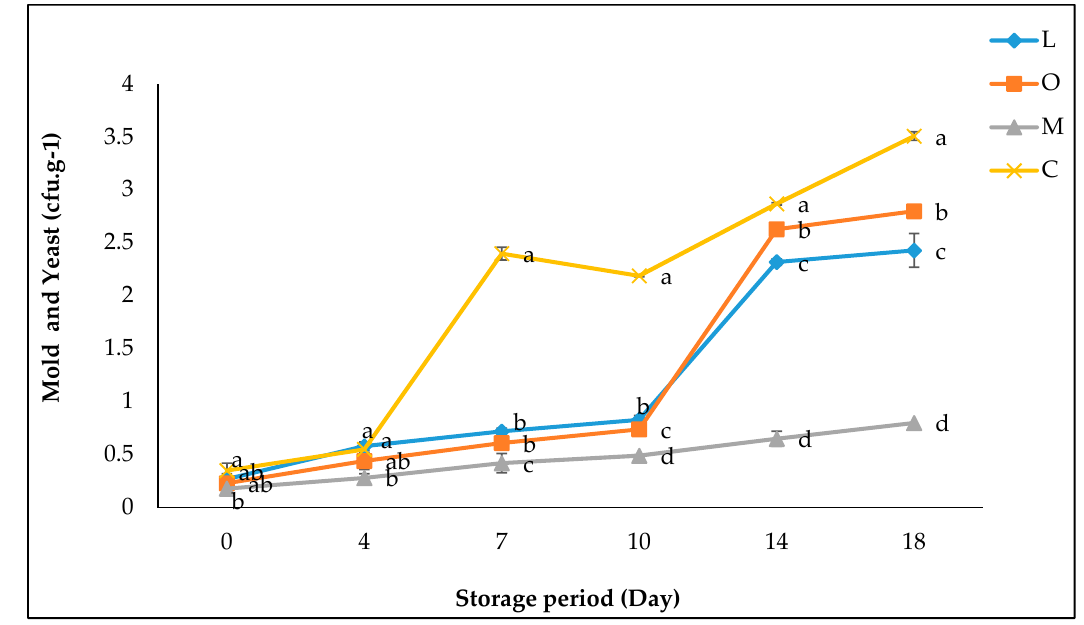
indicate the standard deviation (n = 6). Means and different letters indicate significant difference between treated and control fruits at each storage period (Duncan’s of 95%).